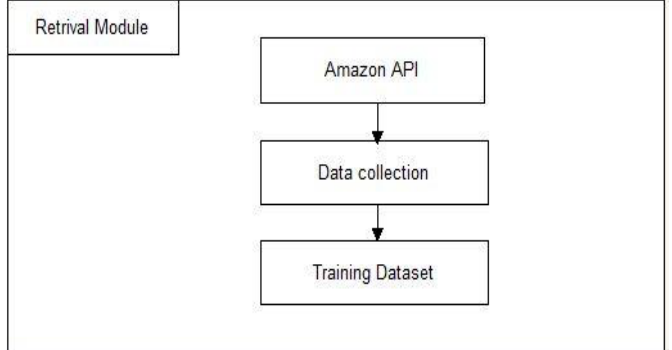
Figure 1. Retrieval Module